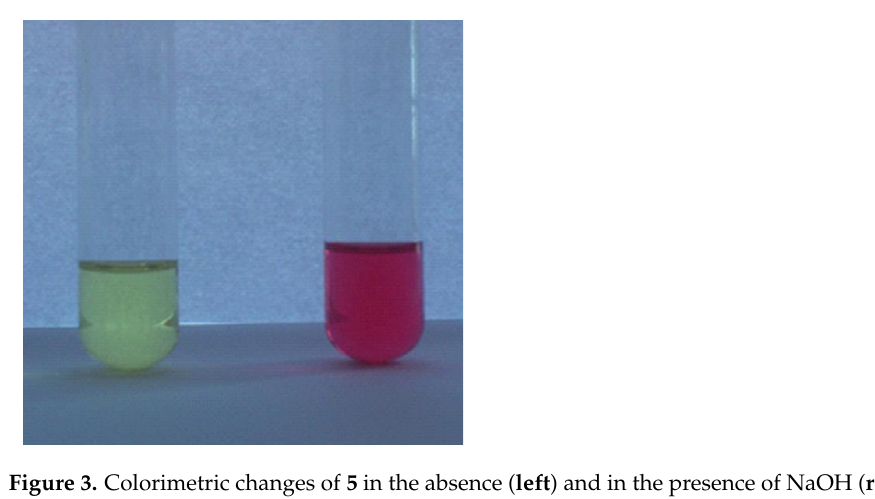
Figure 2. ( A ) Absorption of sensor 5 at different pH and ( B ) titration plot of 5 at λ A = 508 nm in a pH range of 7–14.